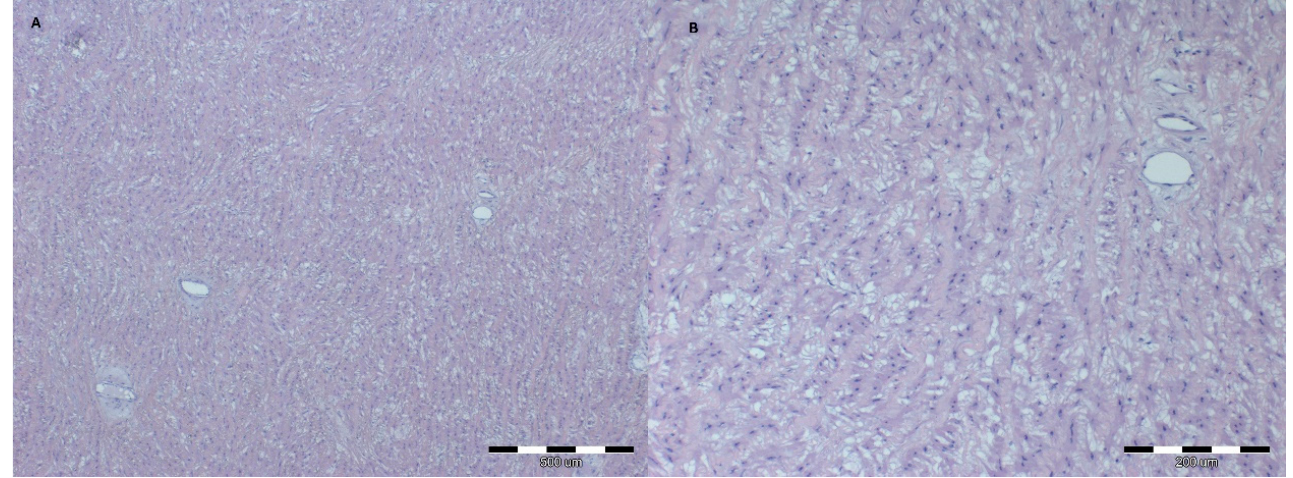
Figure 5. Microscopic image of the aorta specimen from an extremely obese horse. Aortic wall: relaxation of the fiber system, structure disturbance, cell vacuolization; HE staining, 40× ( A ), 100× ( B ). The intima was thicker in examined group as compared to control group in pulmonary artery ( p = 0.04), coronary arteries ( p = 0.04) and palmar arteries ( p = 0.03) (Figures 7–9). Palmar arteries in the examined group showed higher values of lumen diameter ( p = 0.01) and lumen-to-total diameter ratio ( p = 0.01) as compared to the control group. The blood chemistry, including troponin, ghrelin and leptin results, are presented